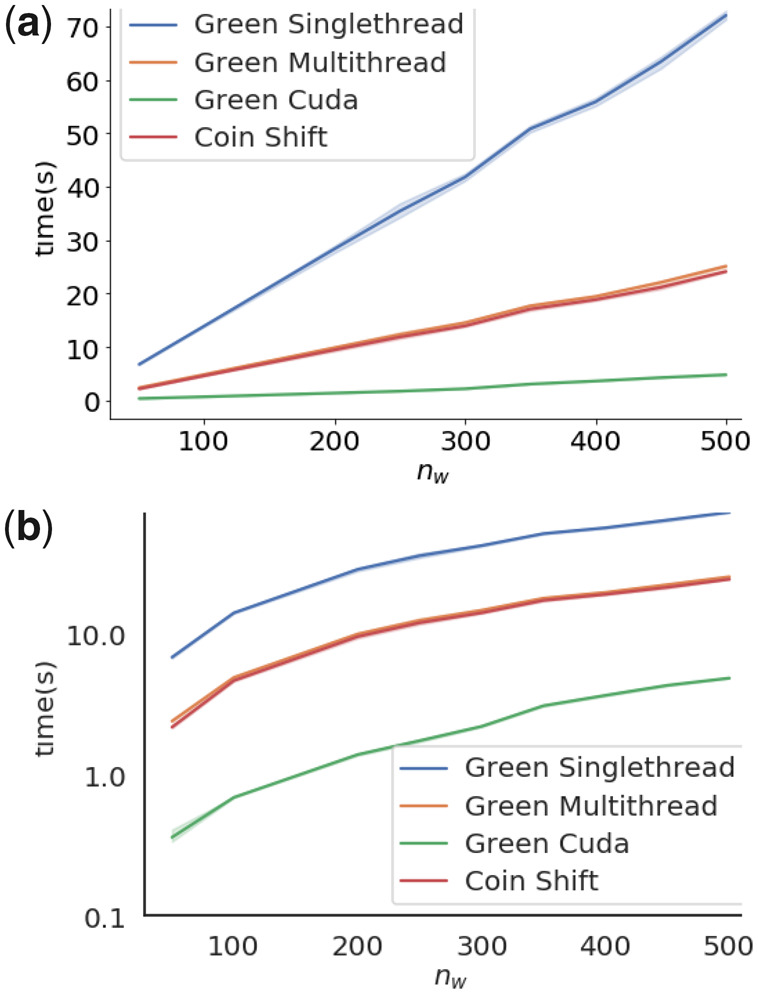
Running time as a function of the number of discretization windows. We plotted the mean of the mean and standard deviation of the required running time, as wall time, as a function of the number of discretization windows, nw. Time was plotted (a) in normal scale, and (b) log-scale. Note that the similarity in execution speed makes it hard to separate the series for Green Multithread and Coin Shift. Also note that the other methods were excluded from the plot, as the discretization step is exclusively present in the Green algorithm